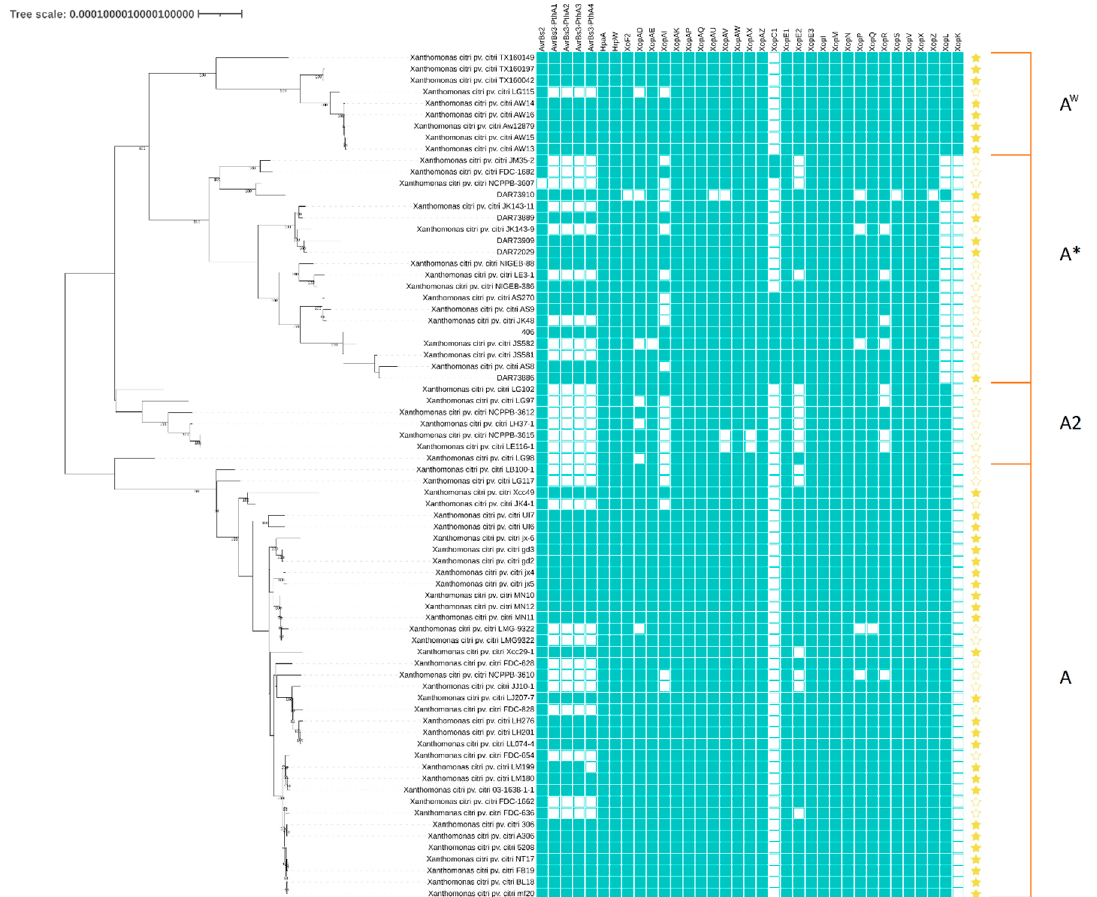
Figure 1. Maximum likelihood phylogeny with 100 bootstrap replicates, midpoint-rooted of a recombination filtered alignment of 4,246,524 bp core Snippy alignment across 74 Xanthomonas citri pv. citri genomes. Presence/absence of type III secreted effectors also shown (green) and complete level genomes are represented with a filled star (yellow). Tree scale is represented as number of substitutions per site.